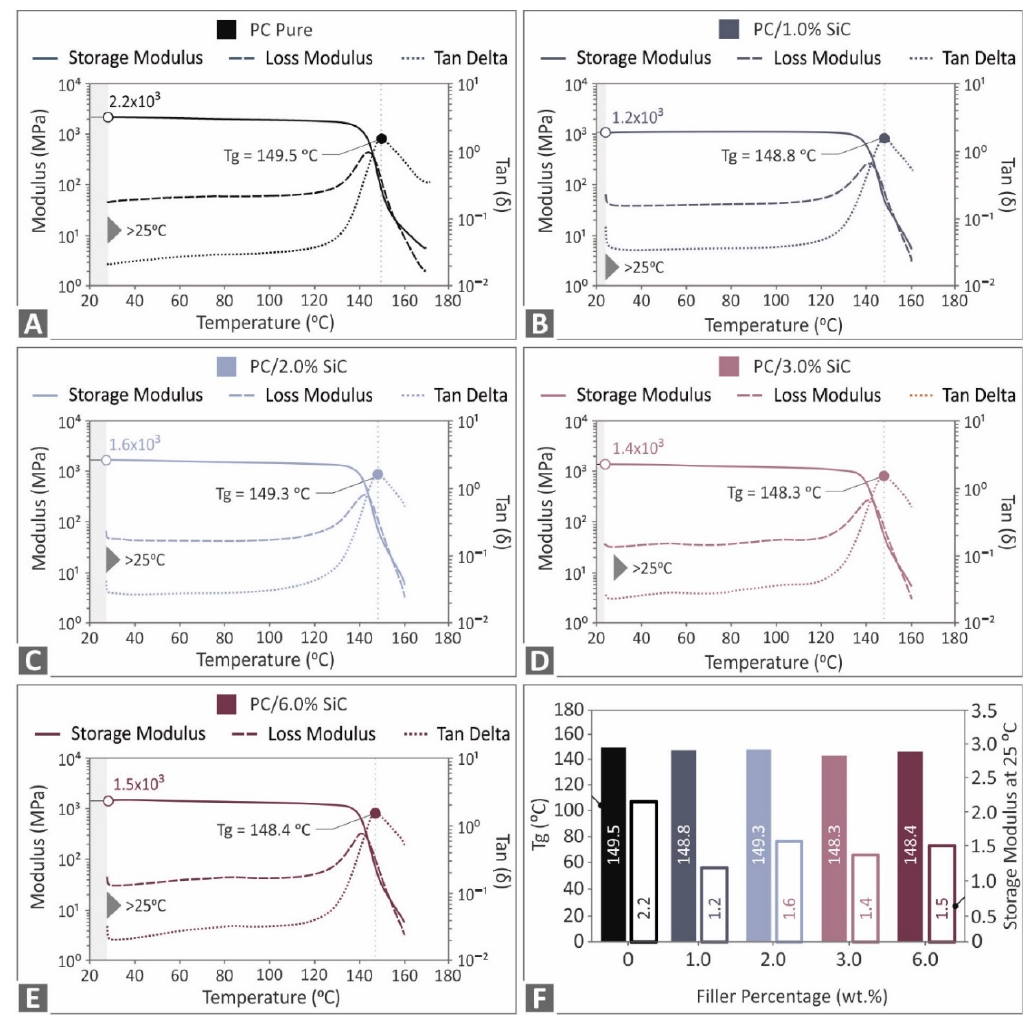
Figure 5. DMA tests results (storage modulus, loss modulus, and tan (delta)), PC: ( A ) pure, and nanocomposites with SiC at loadings of ( B ) 1 wt.%, ( C ) 2 wt.%, ( D ) 3 wt.%, ( E ) 6 wt.%, and ( F ) glass transition temperature Tg (°C) at 25 °C, and the corresponding storage modulus values.